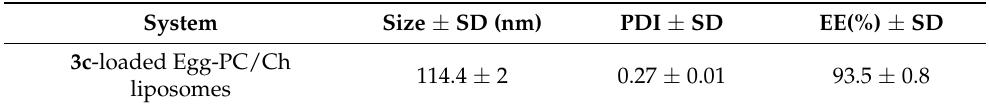
Table 1. Mean hydrodynamic size, polydispersity index (PDI) and encapsulation efficiency (EE (%)) for 3c -loaded liposomes (SD: standard deviation from three independent assays).